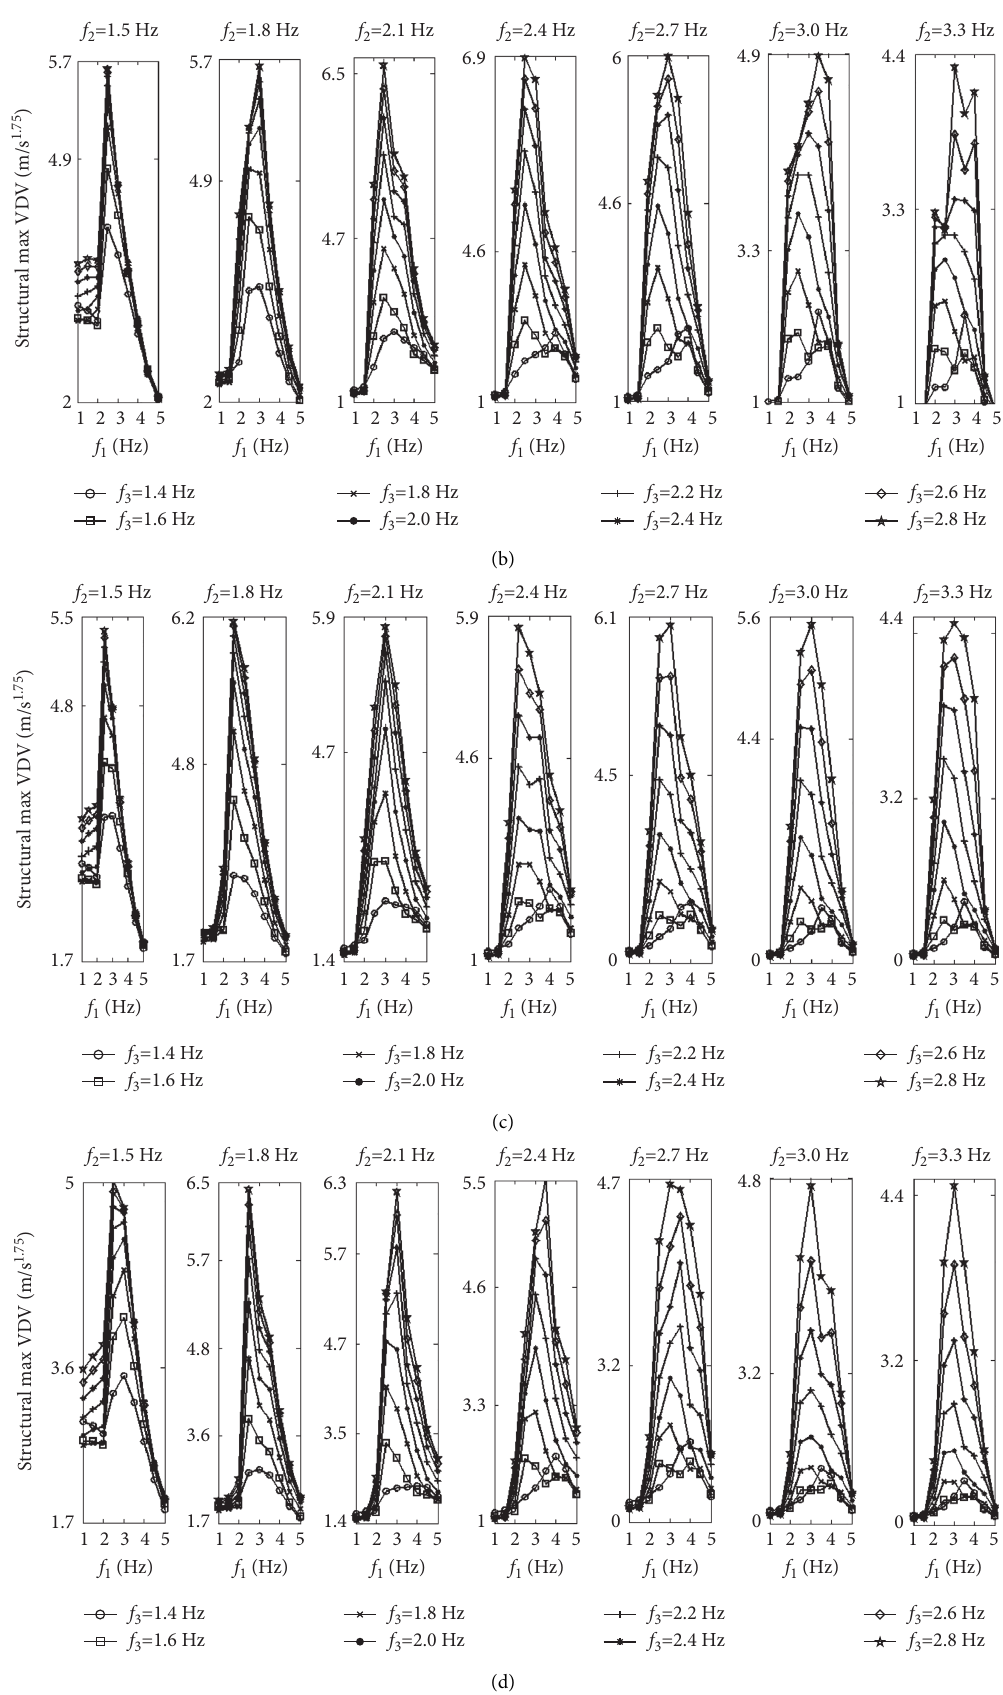
Figure 27: The structural parameters plotted against VDVs with different f model results when α � 0.3, (c) the model results when α � 0.4, and (d) the model results when α �